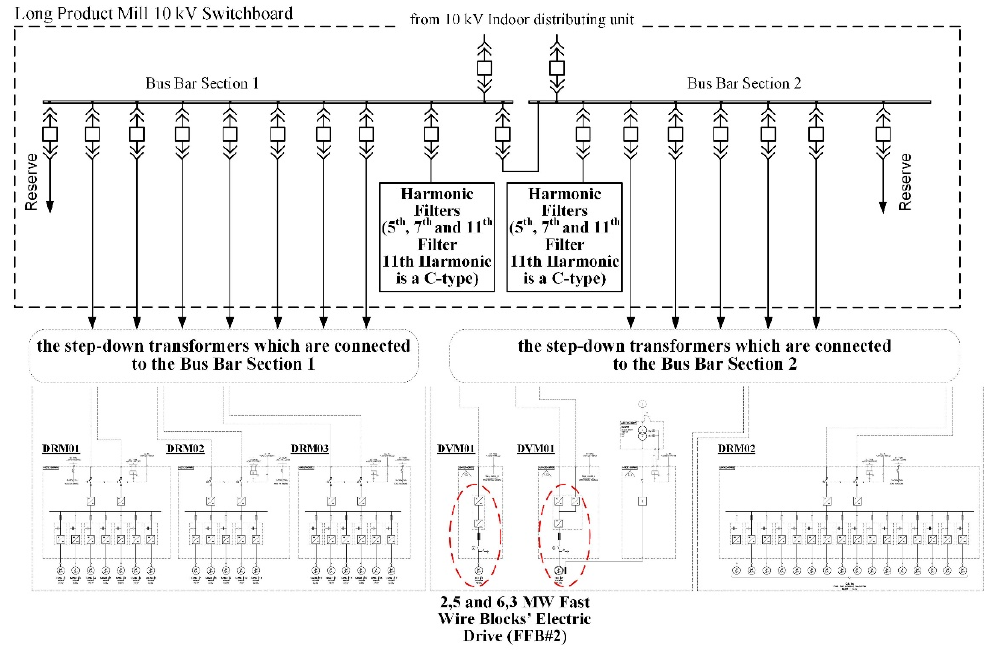
Figure 16. The simplified power grid for the bar mill electric drives.